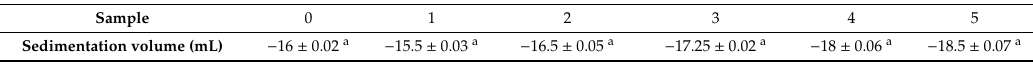
Figure 3. Schematic of crosslinking reaction in the adhesives.